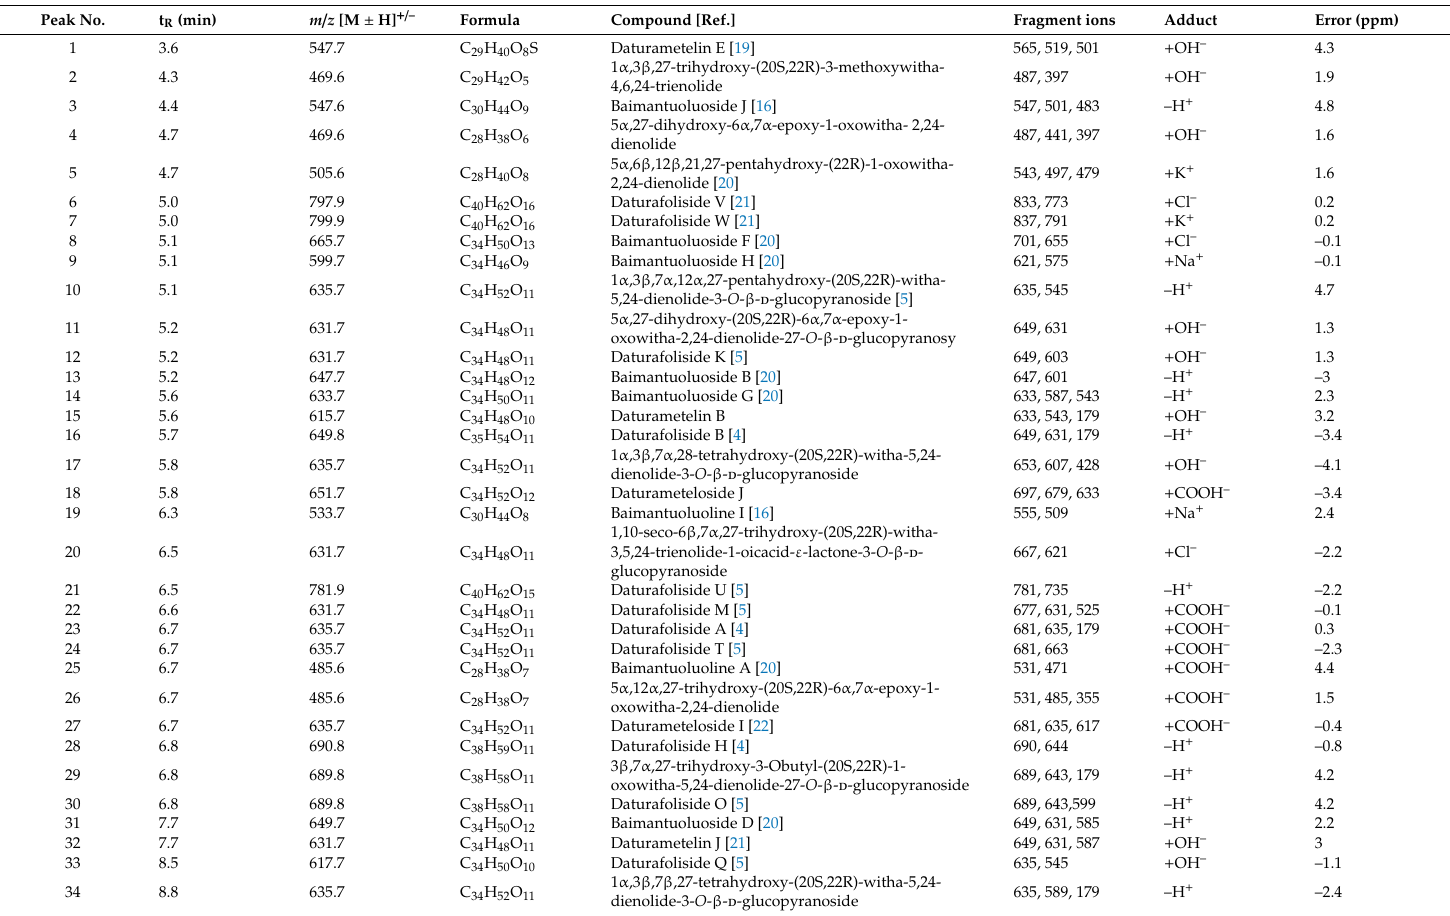
Table 1. Withanolide identification data of Datura metel L. ( D. metel L.) by ultra-performance liquid chromatography tandem time of flight mass spectrometry (UPLC-Q-TOF-MS / MS). Peak No. Compound